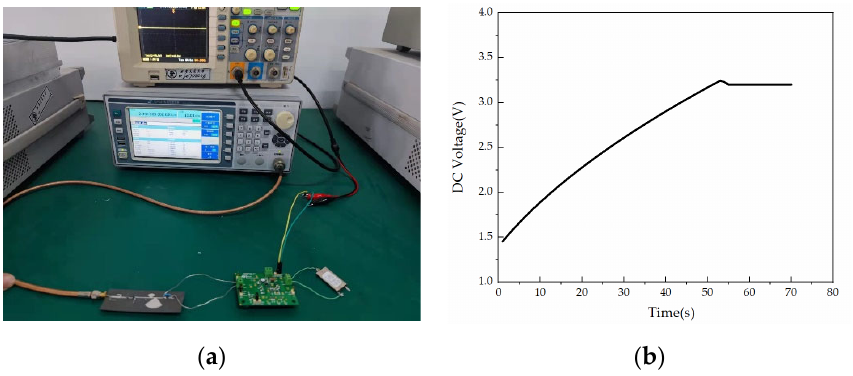
Figure 20. The conversion efficiency measurement. ( a ) Measurement setups; ( b ) DC Voltage across the supercapacitor.